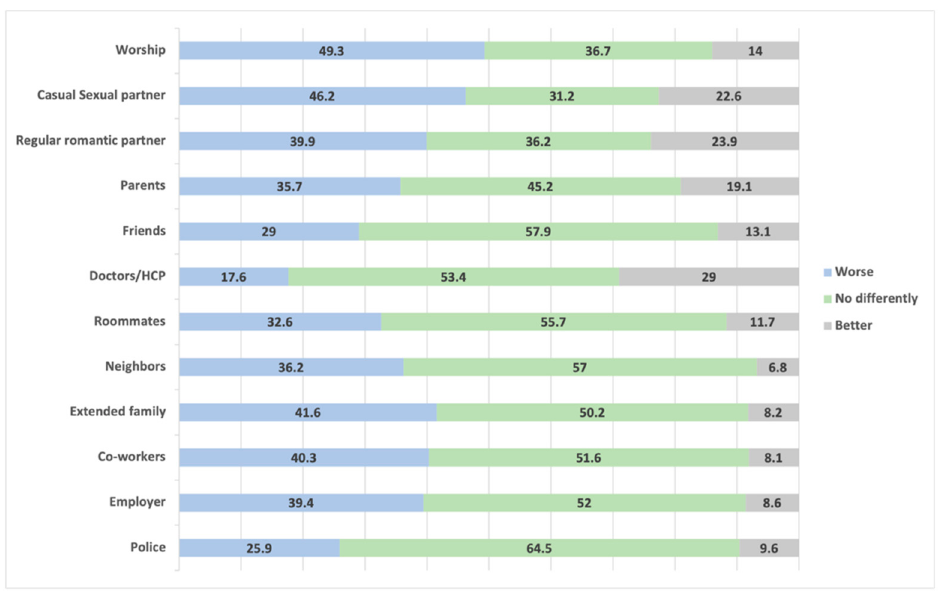
Figure 1. Percentage of participants who perceive they would be treated better, worse, or no differ- ently by specific individuals or groups after disclosing they had been tested for an STI.